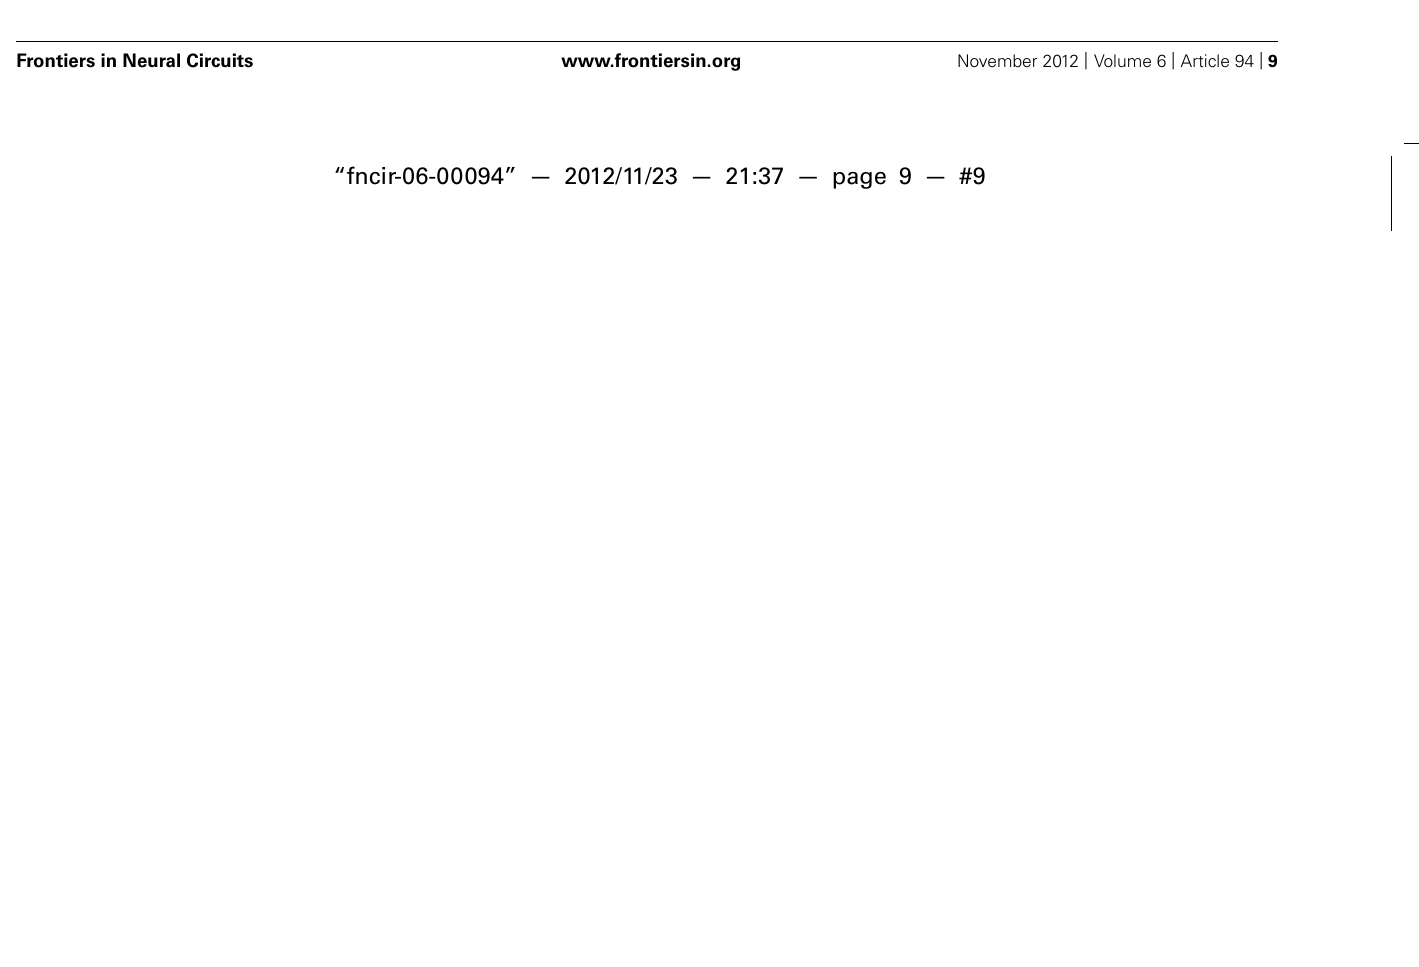
lines + symbols: open circles, upward triangles, downward triangles and diamonds indicate 0.03, 0.1, 0.3, and 1 μ MTHDOC on top, respectively. Notice in (D) that, with respect to the 0.1 μ M GBZ pre-conditioning (continuous line) data are gradually left-shifted by the increasingTHDOC concentrations, thus suggesting a corresponding decreased excitability and a decreased number of engaged neurons (line + diamonds) only at 1 μ MTHDOC (THDOC concentrations lower than 30 nM were out of